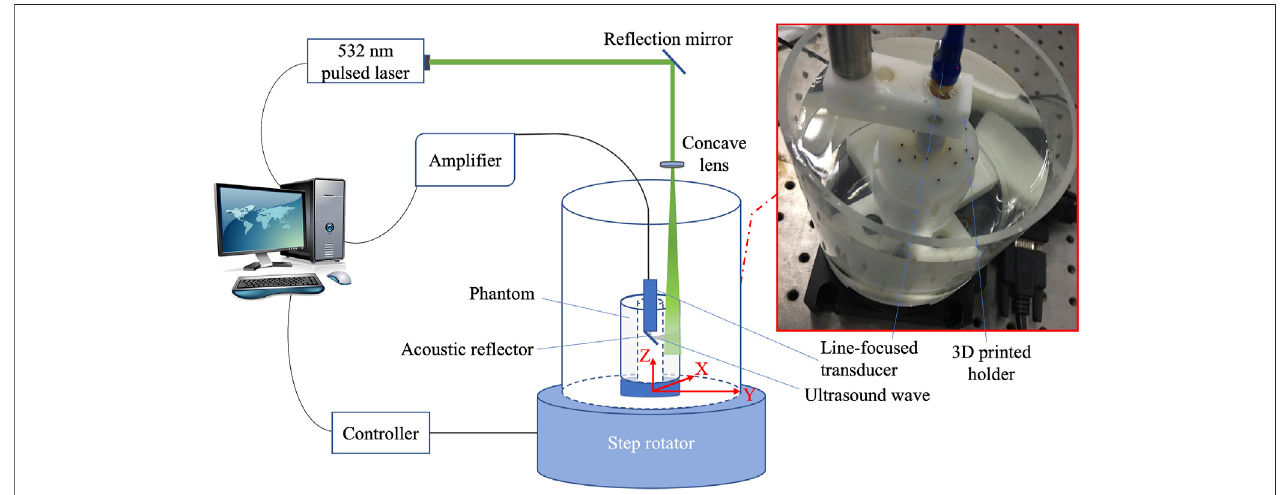
FIGURE 2 | Experimental system diagram of photoacoustic/ultrasonic